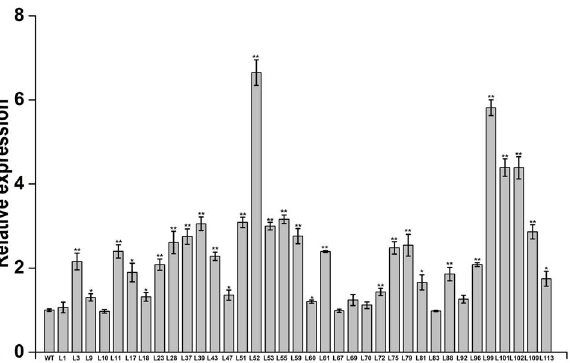
Fig. 6. Expression analysis of IbMas gene in the transgenic sweetpotato plants by real-time quantitative PCR. The 36 transgenic and wild-type (WT) in vitro-grown plants were submerged in 1/2 MS medium with 200 mM NaCl for 12 h to analyze the expression of IbMas . The sweetpotato b -actin gene was used as an internal control. The results are expressed as relative values based on WT as reference sample set to 1.0. Data are presented as means ¡ SE (n 5 3). * and ** indicate a significant difference from that of WT at P , 0.05 and , 0.01, respectively, by Student’s t -test.